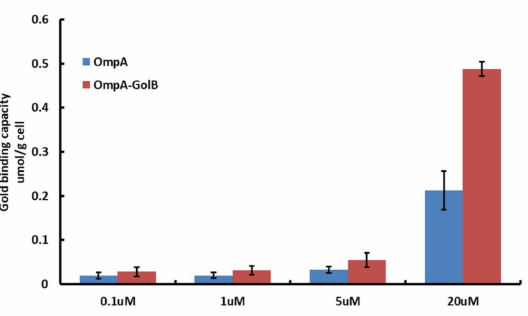
Figure 4. Gold adsorption of surface displayed E. coli strains containing OmpA or OmpA-GolB was induced by 20 µ M HAuCl 4 (Au 3+